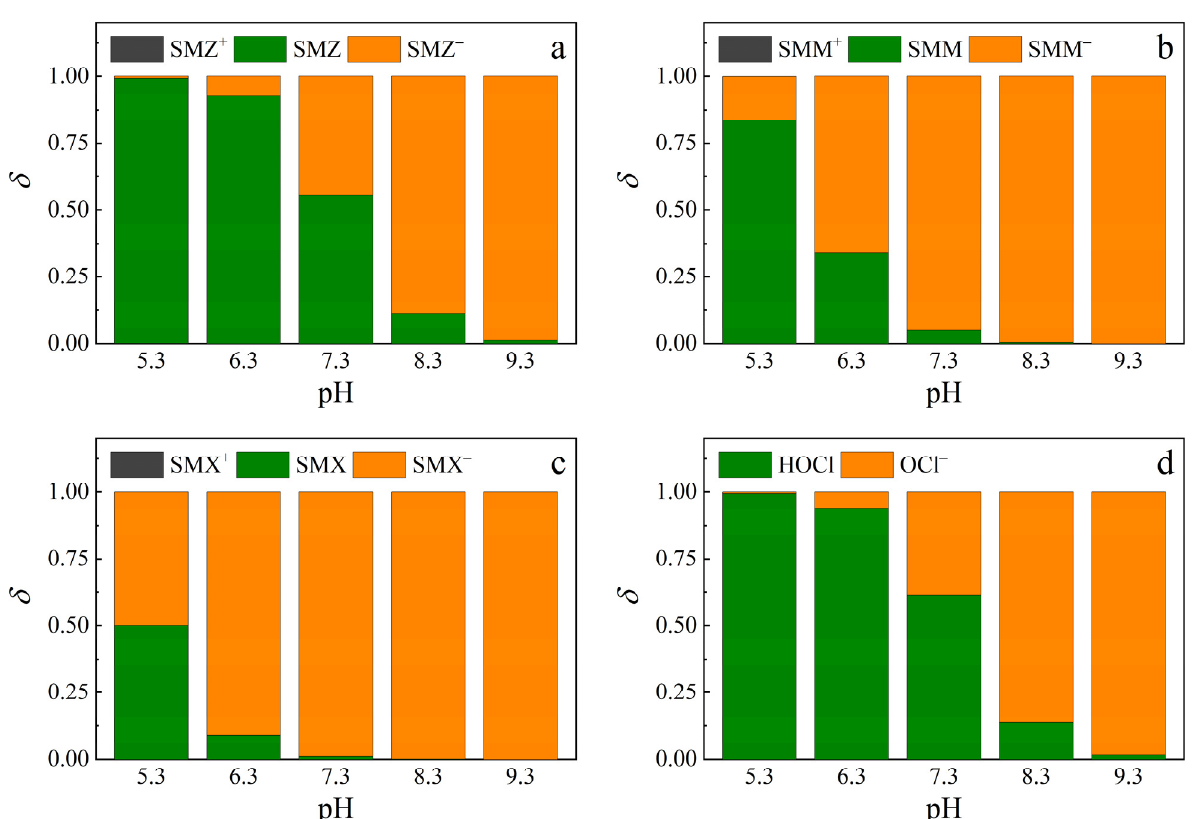
Figure 6. Distribution coefficients ( ẟ ) of sulfonamides (“+”, no mark, and “–” represent cationic, neutral, and anionic species, respectively) and HOCl at different pH. Distribution of ( a ) SMZ species, ( b ) SMM species, ( c ) SMX species, and ( d ) chlorine species.